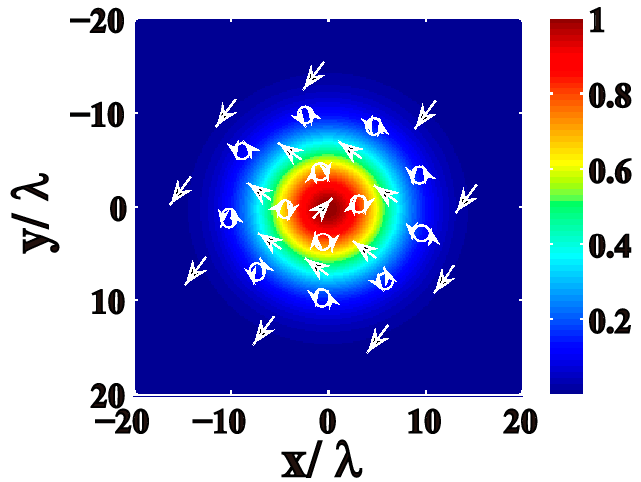
Figure 1. (Color online) The states of polarization (SoP) arrangement in the cross-sections of a radially-variant vector beam (RVVB) with a Gaussian amplitude. Here, λ is the wavelength.